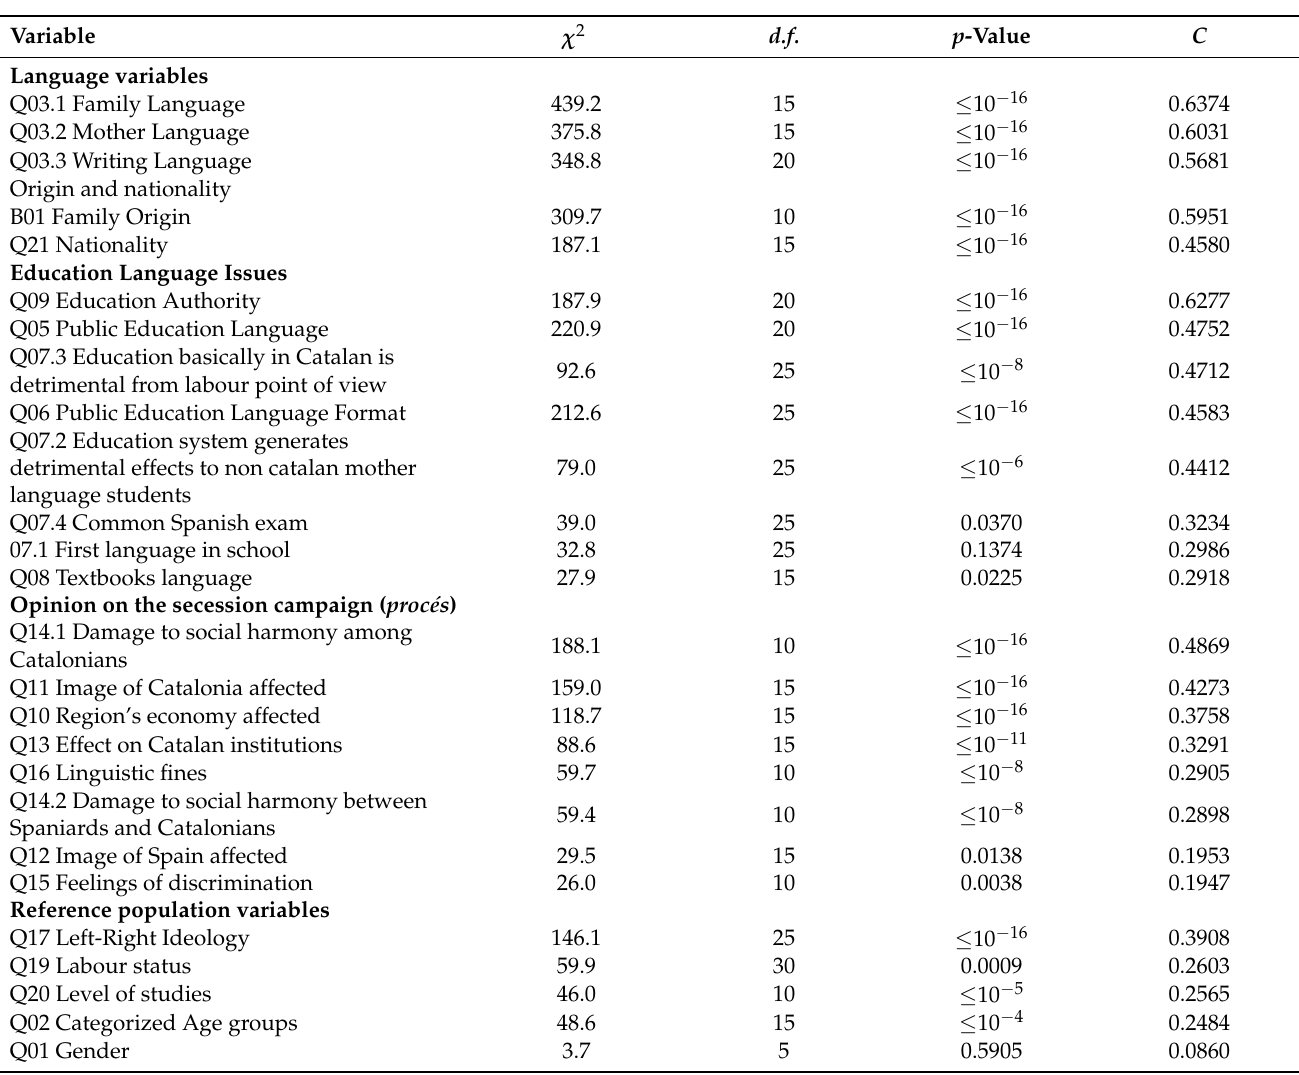
Table 4. Association coefficients between Catalonians with different “ feelings of national identity ” segments and each of the remaining variables surveyed. (These denote different opinions, preferences, and traits derived from a GAD-3 survey in December 2020 with a sample size of n = 1002 (or n = 402 for a group of variables) Catalonian residents. The variables are grouped in consideration of their nature, and each group is presented in descending order, from the top down, of its association magnitude, as measured by the contingency coefficient, C . Only the variables of “ gender ” and “ first language in school ” present an insignificant stochastic dependence on “ feelings of national identity”, while all of the remaining variables exhibit a clear stochastic dependence on this